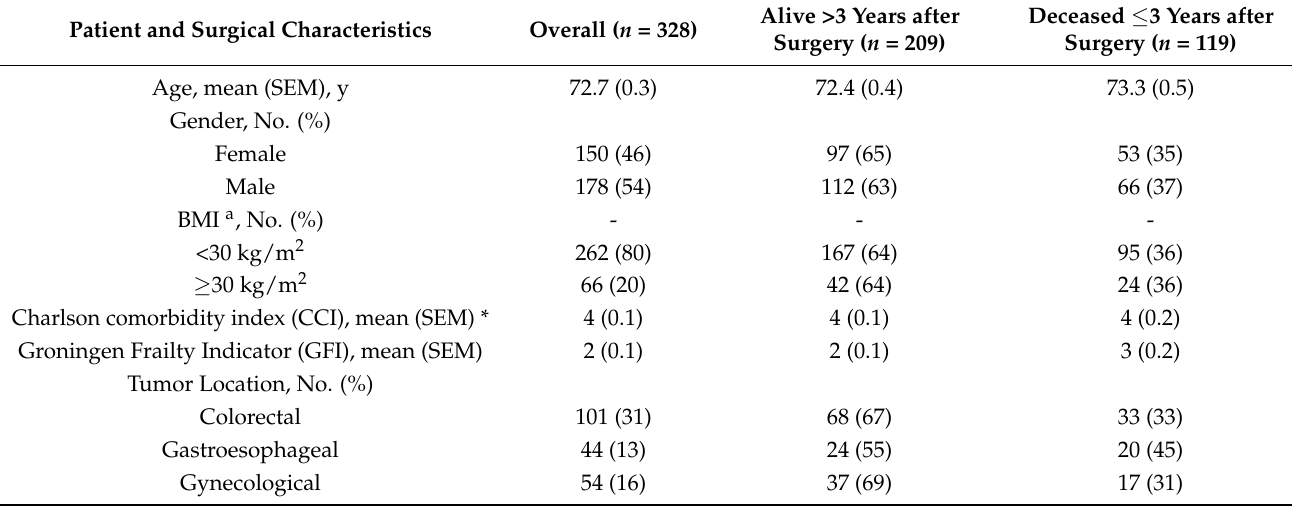
Figure 1. Study flowchart. Table 1. Patient and tumor characteristics ( n = 328).